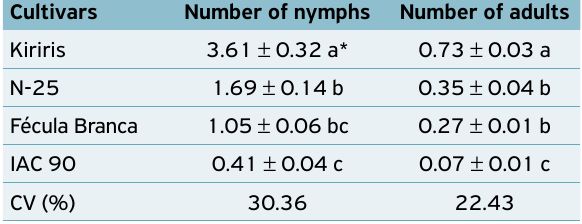
*Means followed by the same letter in the column are not different at 5% of probability, by Tukey´s test.